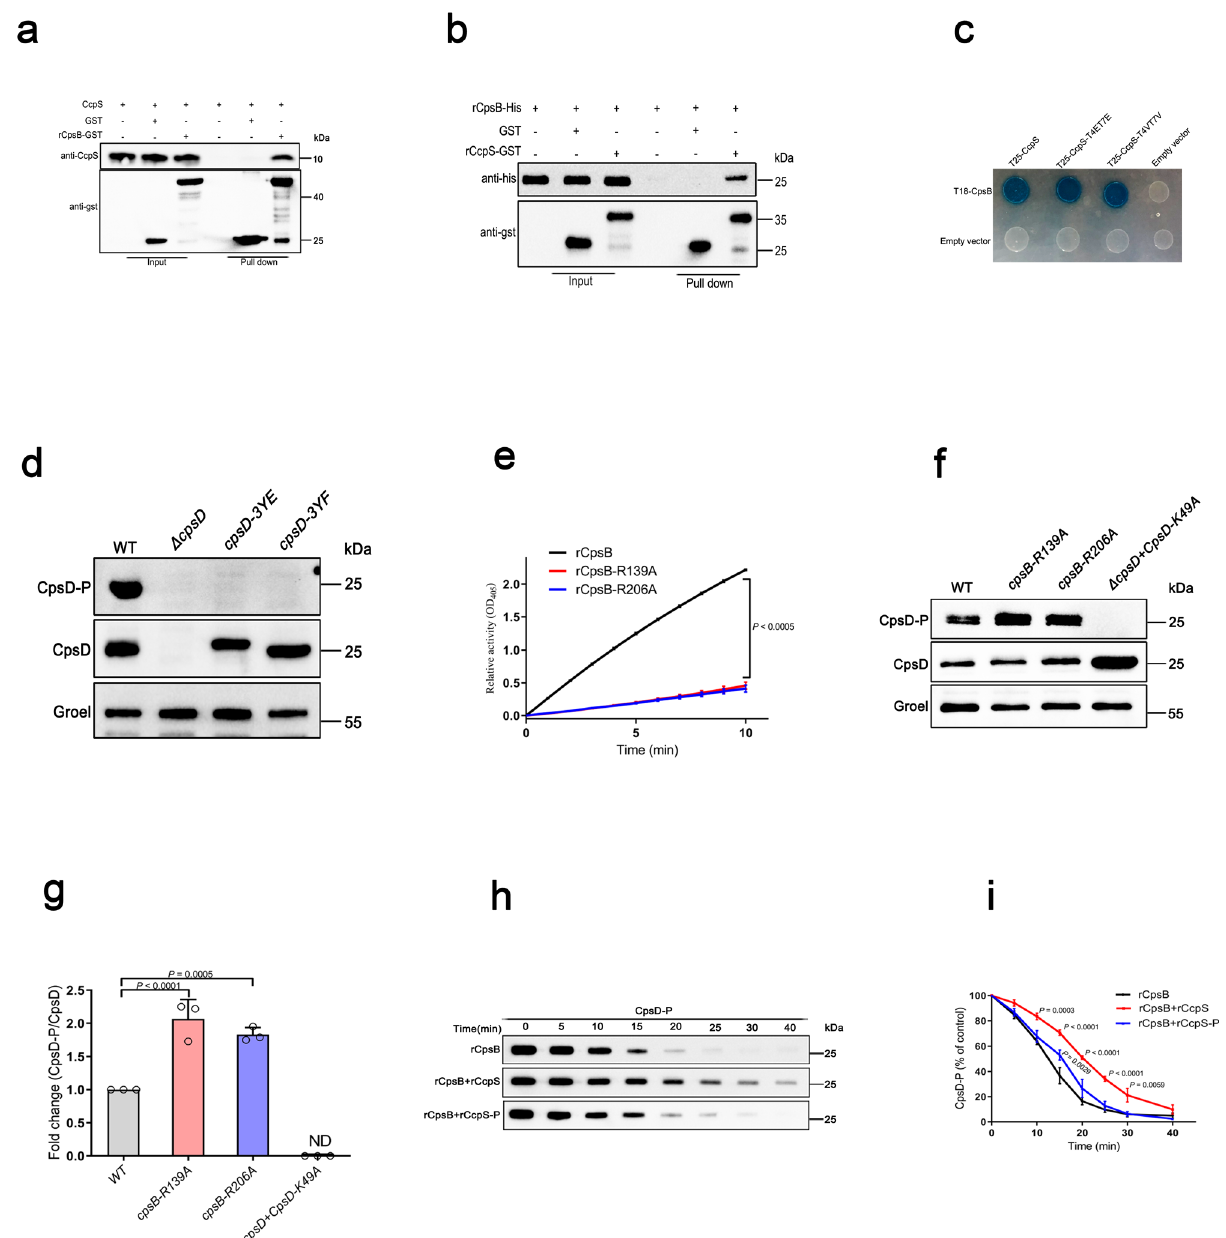
Fig. 4 | CcpS binds to and modulates CpsB activity. a Af fi nity puri fi cation of rCpsB-GST from S. suis whole-cell lysates pulls down native CcpS and empty GST- tag as control, GST agarose beads capture protein complexes, and the samples were detected with anti-GST and anti-CcpS antibodies, respectively. b Pull-down assaycon fi rmedthedirectinteractionbetweenCcpSandCpsB.Puri fi edrCcpS-GST or empty GST-tag were incubated with rCpsB-His, and protein complexes were capturedbyGSTagarosebeads,washed,andelutedinthesamplebuffer.Fractions were probed with anti-GST and anti-His antibodies. c Bacterial two-hybrid assay testing for interactions between CcpS and its variants (CcpS-T4ET7E and CcpS- T4VT7V) with CpsB. Blue colony formation suggests that a direct interaction occurs. d , f Anti-phosphotyrosine immunoblot analysis of whole-cell lysates from the indicated strains. Immunoblot shows phosphorylated CpsD and total CpsD protein levels using anti-phosphotyrosine and anti-CpsD antibodies, respectively. Groel: loading control. e Biochemicalcharacterizationof the activitiesof CpsBand itsvariants(CpsB-R139AandCpsB-R206A)usingpara-nitrophenylphosphatepNPP, which is an arti fi cial substrate. The recombinant rCpsB activity was normalized to Western blot densitometries of CpsB and its variants for each sample, and the WT